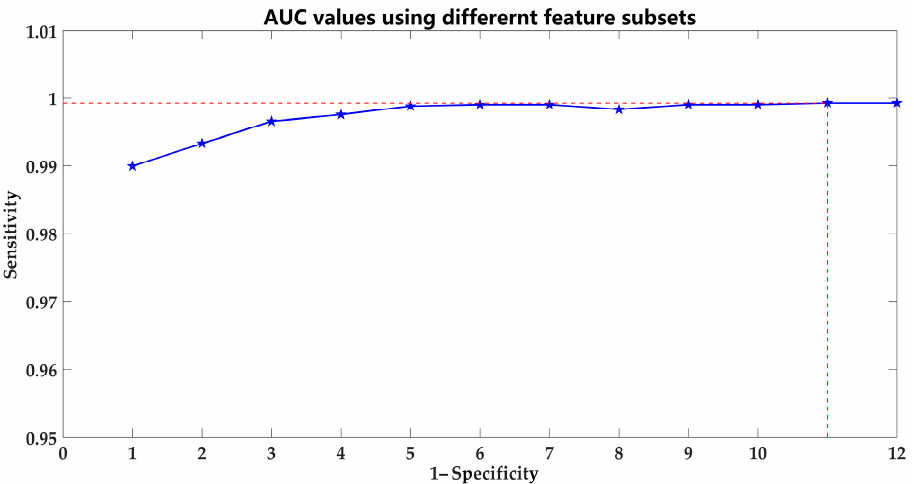
Figure 11. AUC values using di ff erent feature subset. The optimal feature subset is the Top-11 ranked features.